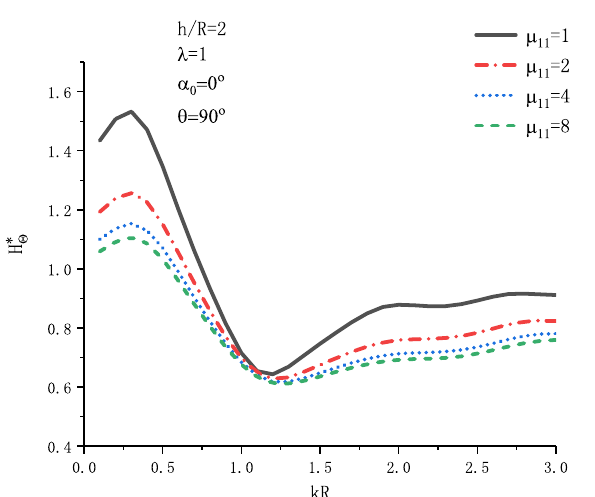
* kR when SH wave incident horizontally ( µ 11 ). θ vs.